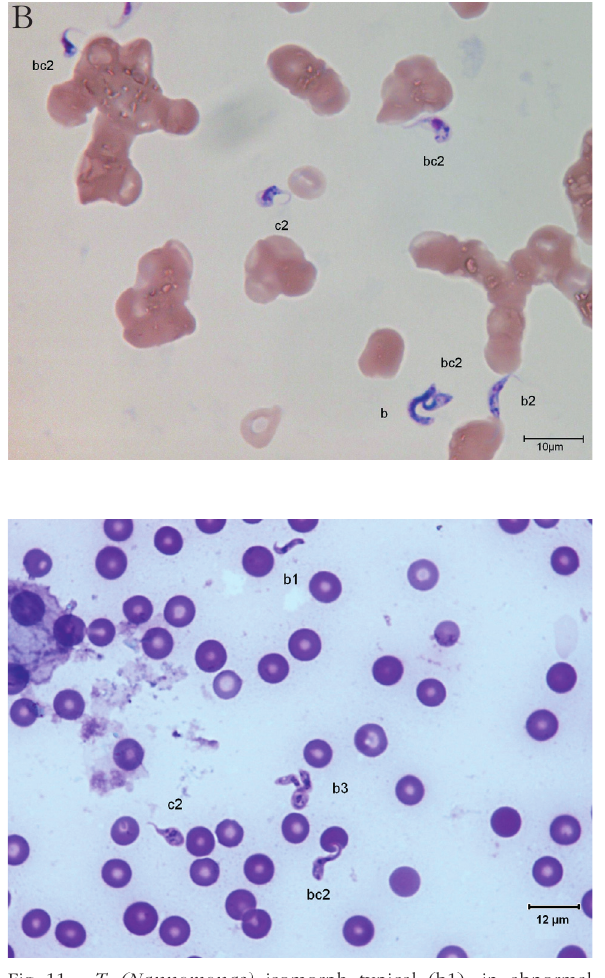
Fig. 11. – T. (Nannomonas) isomorph typical (b1), in abnormal division (b3), and intermediary forms (bc2) toward the congo - lense -sphaeromorph with a free flagellum (c2). Photo by Marc